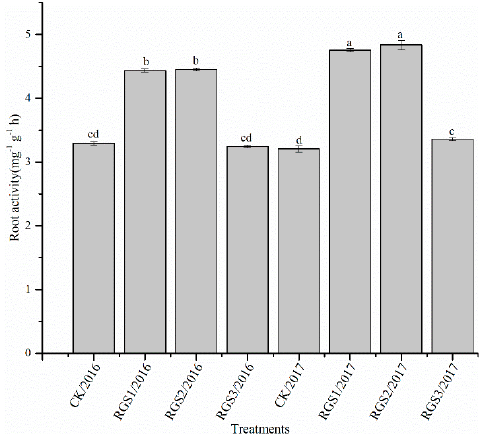
Figure 4. Effect of amendment with raw garlic stalk on root activity of eggplant. The error bars represent standard error of the means ( n = 3). Different letters between treatments at different sampling stages show significant difference at p < 0.05 level (ANOVA and LSD).